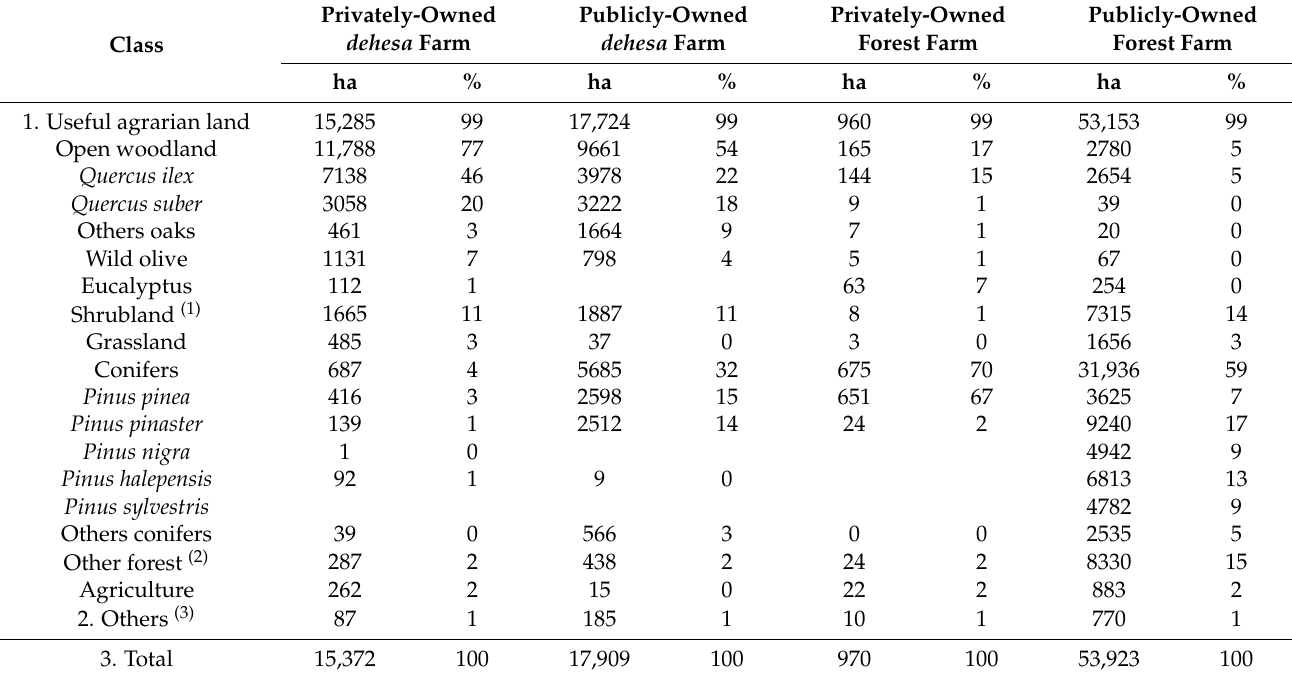
Table 1. Vegetation cover and other land uses in the large dehesa and forest farms case study in Andalusia.